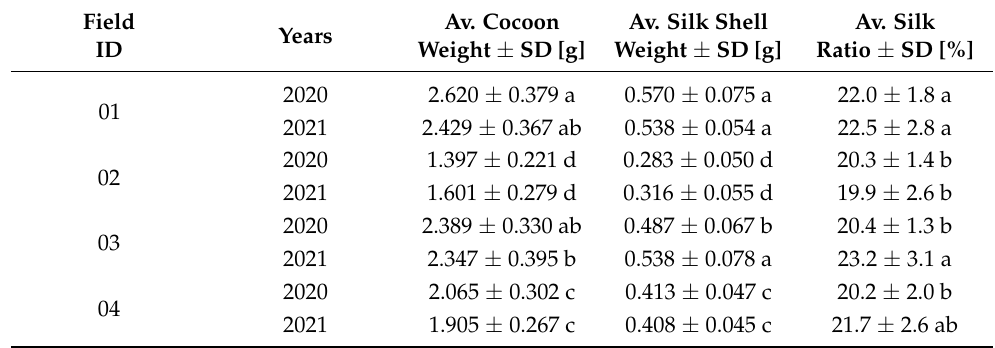
Table 4. Average cocoon weight, average silk shell weight, and average silk percentage of sampled cocoons, divided per farm and per year. Different letters indicate significant differences among samples according to Tukey’s HSD test ( α = 0.05).